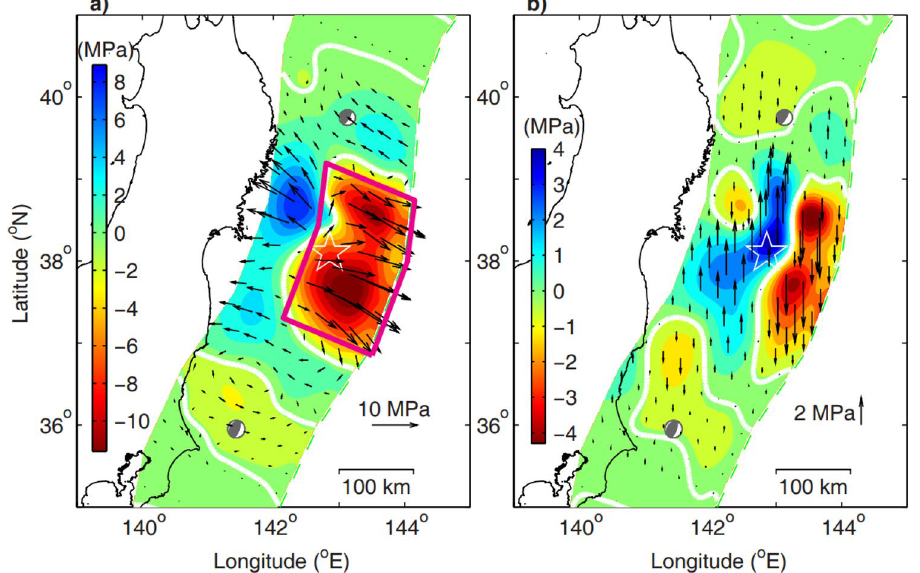
Figure 1. Inverted static coseismic stress changes of the Tohoku-Oki earthquake. ( a ) and ( b ) are the shear and normal stress changes of the Tohoku-Oki earthquake along the fault 18 , respectively, the stress change surrounded by red line are used to recover the ME of the earthquake. The white zero-shear stress drop contour encompasses the rupture areas of the mainshock and the largest M w 7.8 aftershock. Beach balls in the north-east and south- west show focal mechanisms of the aftershocks with M w 7.4 and M w 7.8 occurred at UTC 06:08 and 06:15 on 11 Mach, respectively. The star indicates the hypocenter of the mainshock, the arrows denote the magnitudes and directions of the inversed